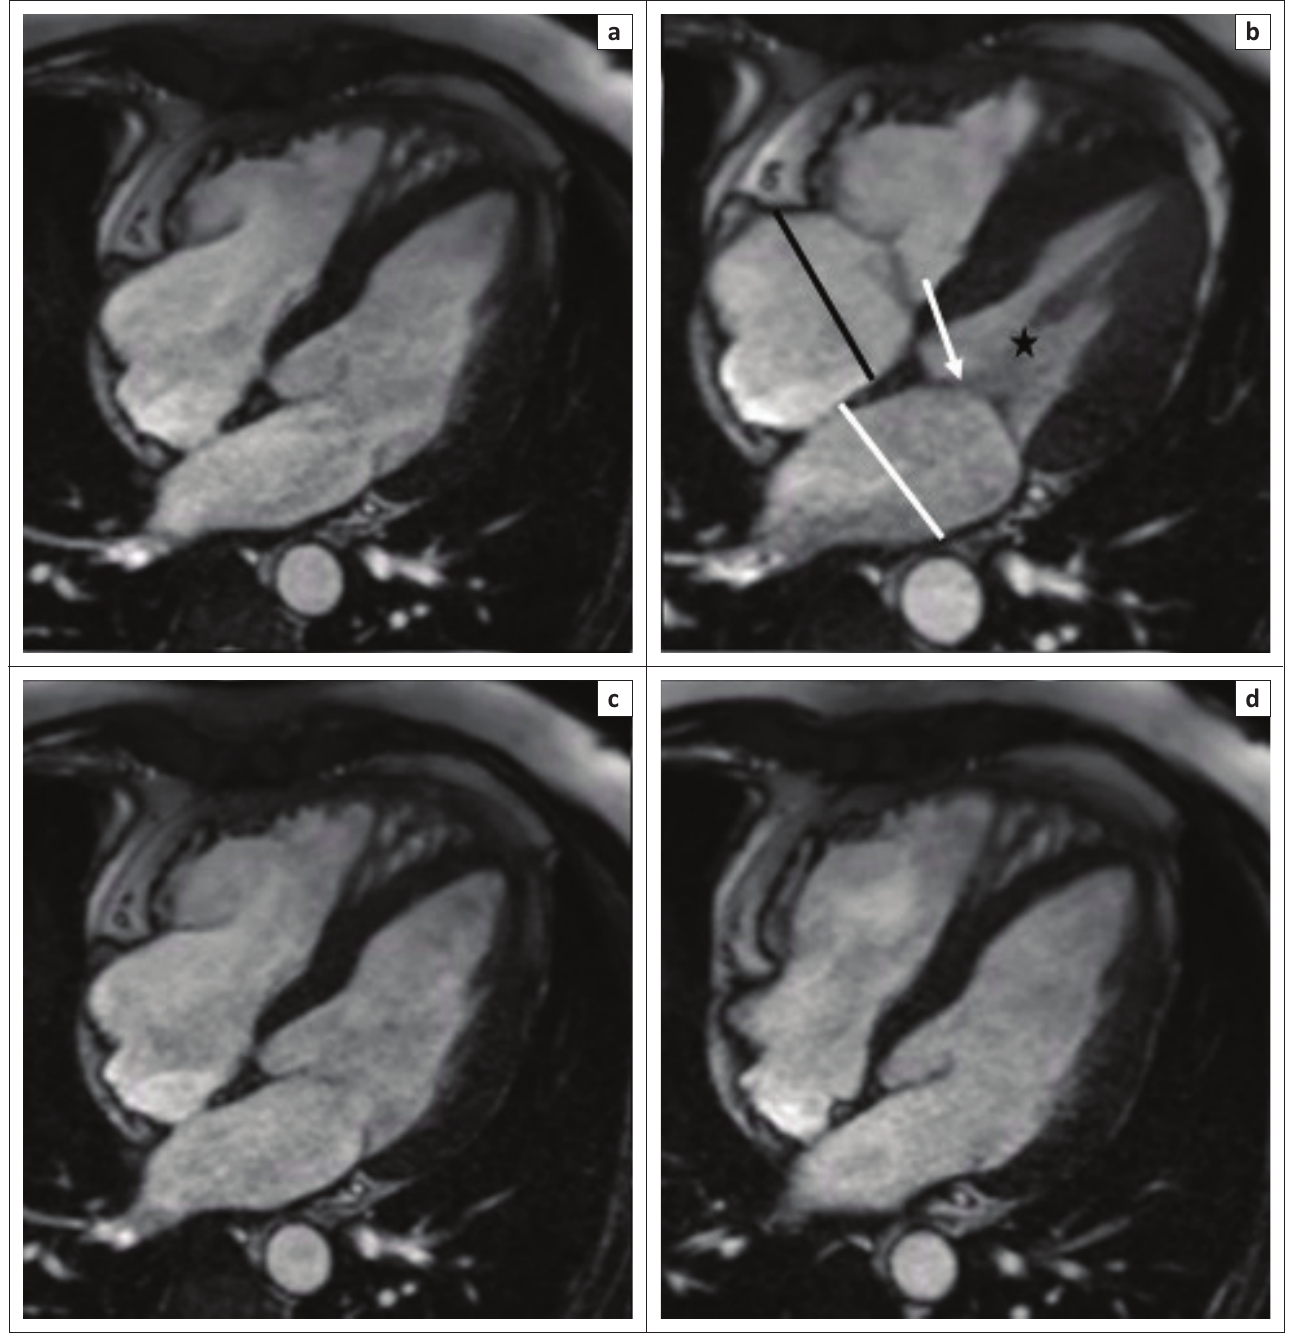
FIGURE 9: Four-chamber cine SSFP images (a–d) of the heart. The atria are measured at the end of the ventricular end-systole when the ventricle blood pool is the smallest ( * ) and the mitral valve is closed (white arrow). The atria can be measured with a transverse measurement at the level of the mid atrium (right atrium – black line; left atrium – white line), avoiding the atrial appendages and pulmonary vein